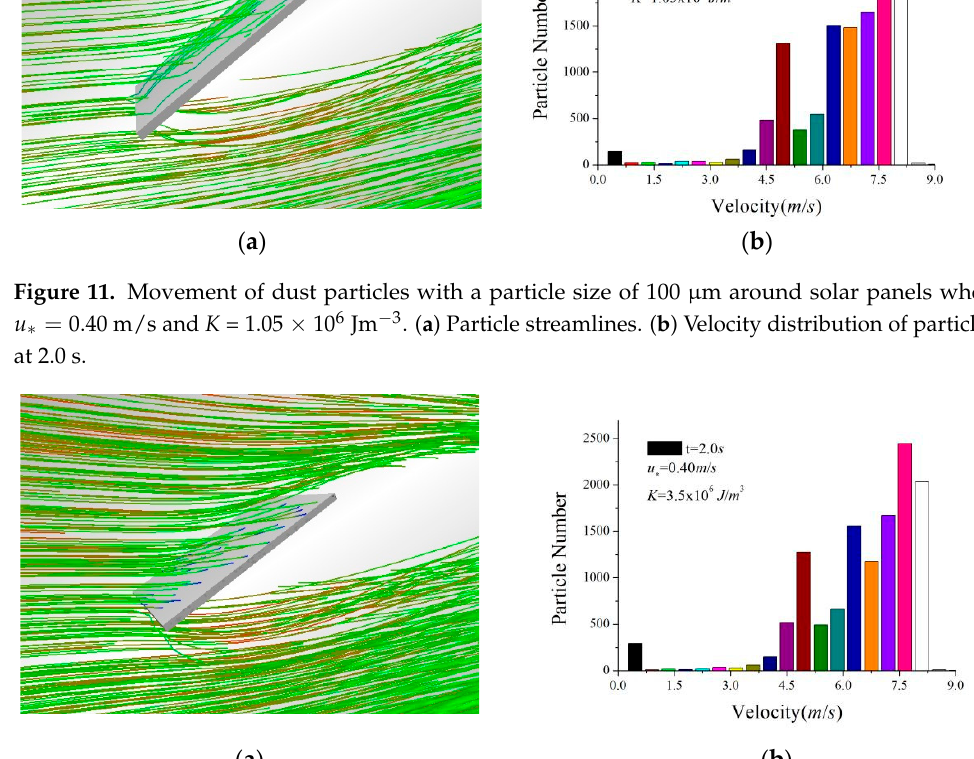
Figure 12. Movement of dust particles with a particle size of 100 um around solar panels when u ∗ = 0.40 m/s and K = 3.5 × 10 6 Jm − 3 . ( a ) Particle streamlines. ( b ) Velocity distribution of particles at 2.0 s.